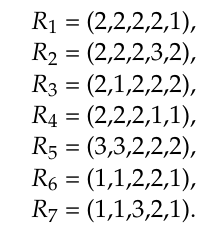
Figure 3. Permutation π 0 —construction project schedule considering LAF.